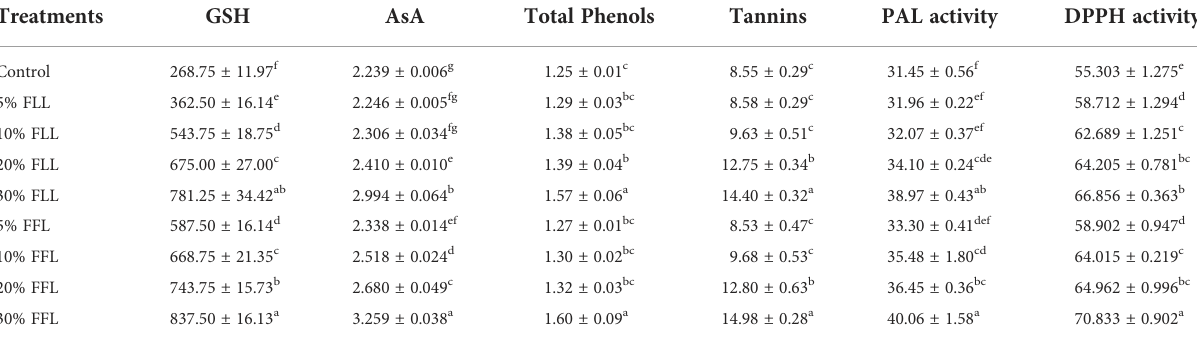
Data followed by same letters are not signi fi cantly different at p< 0.05.